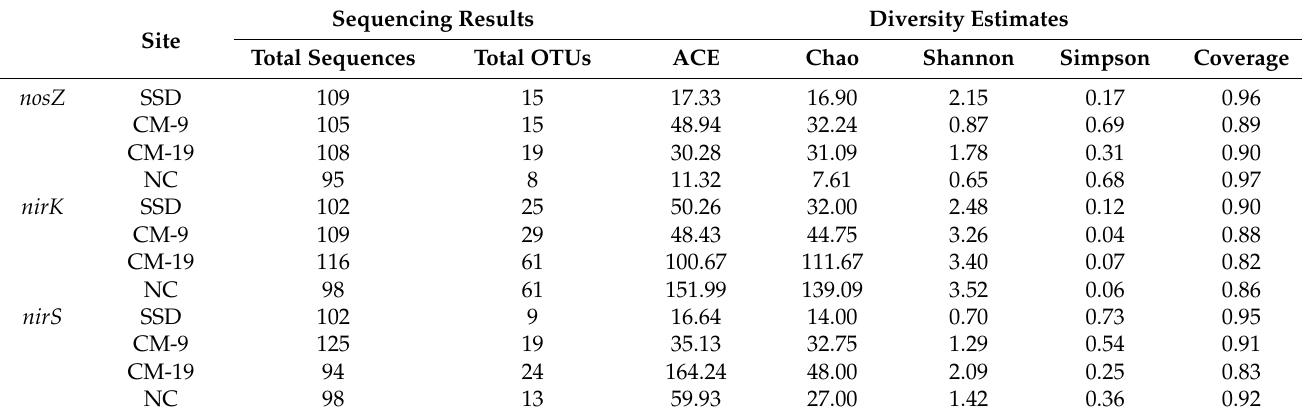
Table 2. Diversity indices of different gene clone